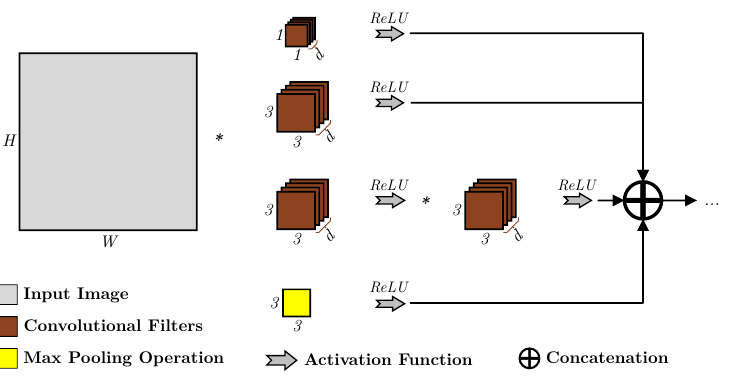
Figure 2. An overview of an Inception v2 layer which replaced the 5 convolutional kernels [17].